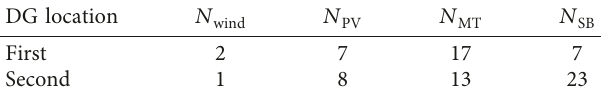
Table 11: The second-layer decision